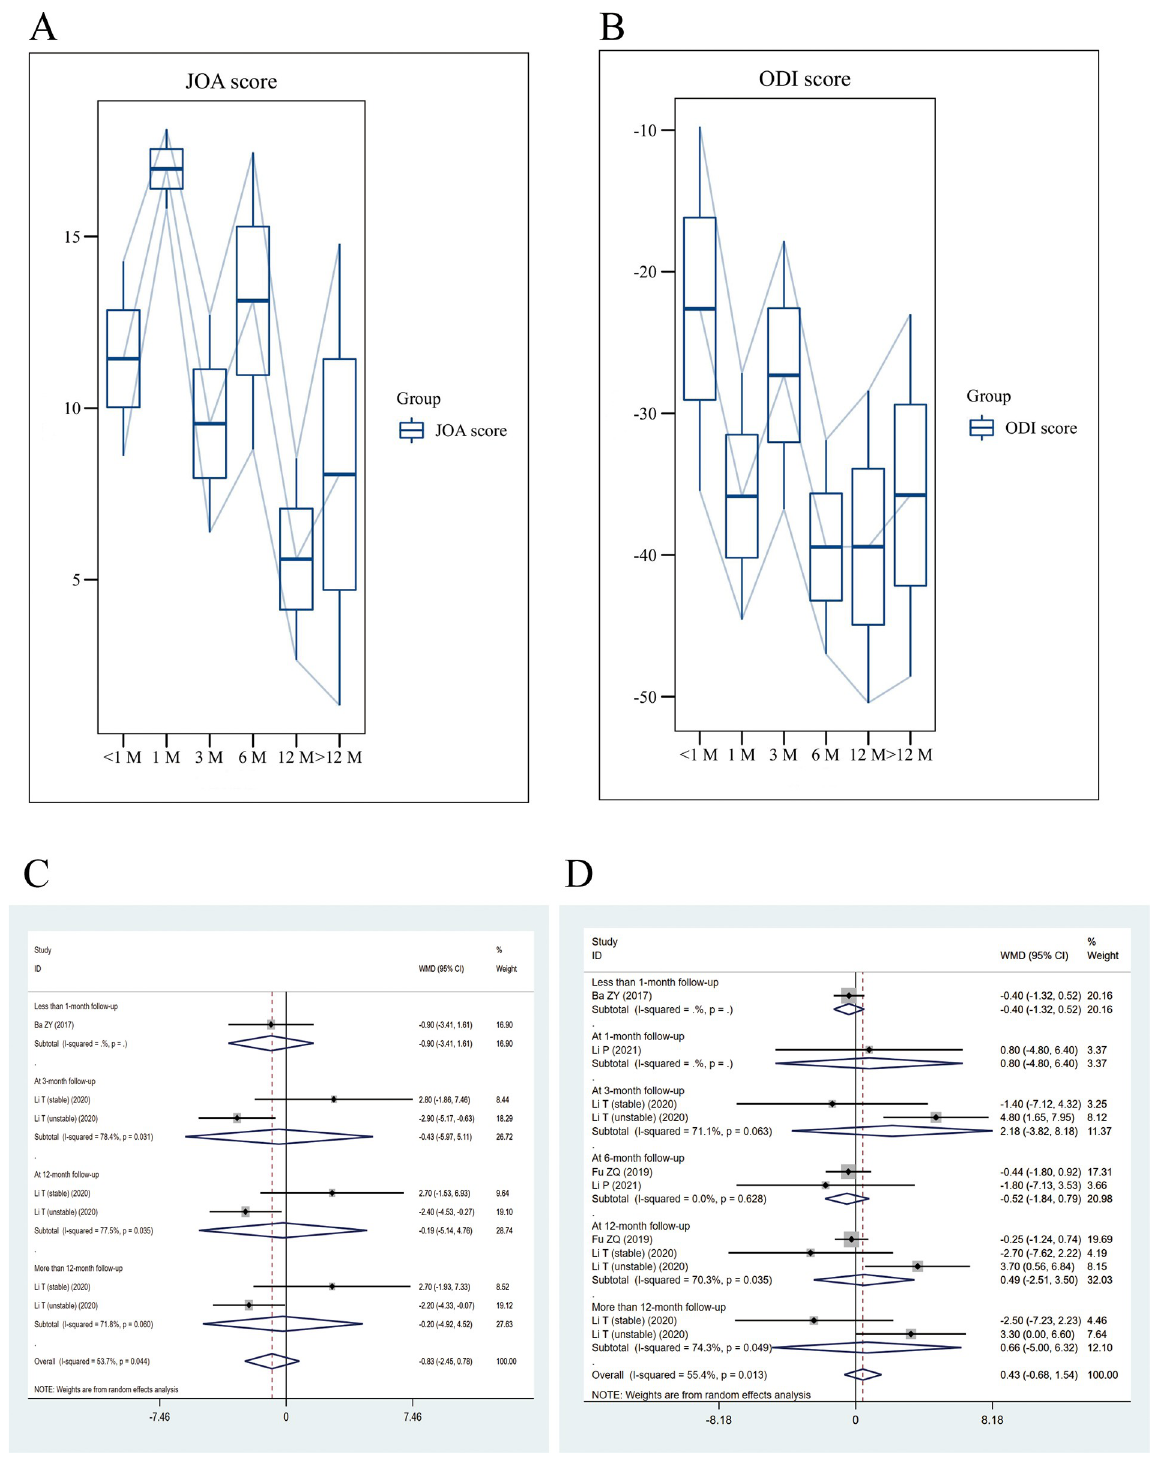
Fig 4. Trend plots for single arm meta-analysis of JOA and ODI and clinical control forest plots. (A) Postoperative JOA trend chart; (B) Postoperative JOA forest plot about clinical trials; (C) Postoperative ODI trend chart; (D) Postoperative ODI forest plot about clinical trials.